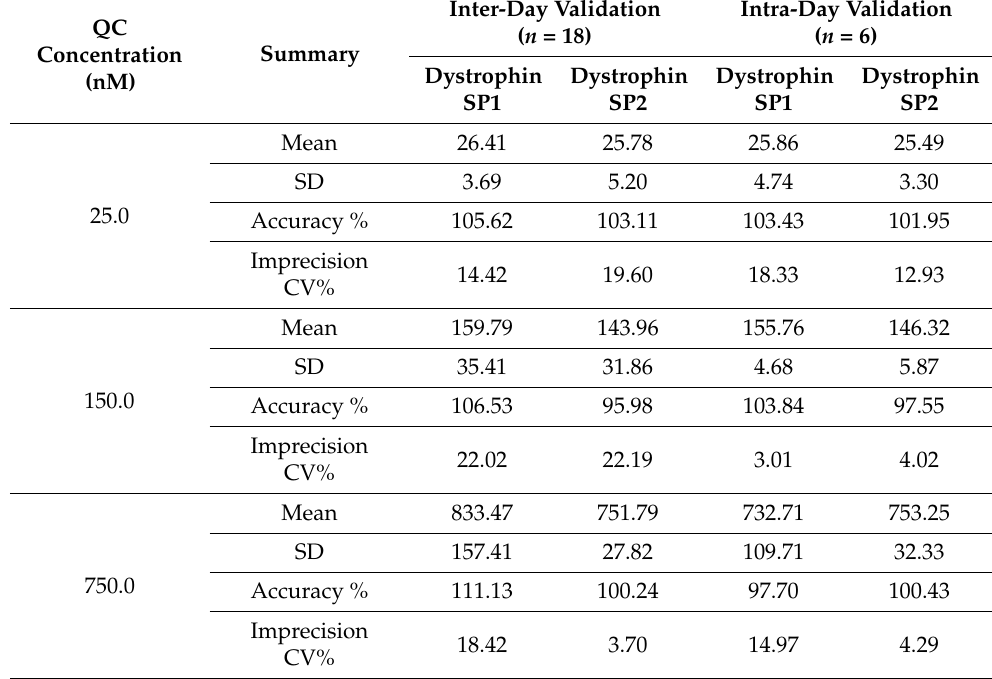
Table 3. Linearity and sensitivity summary over three